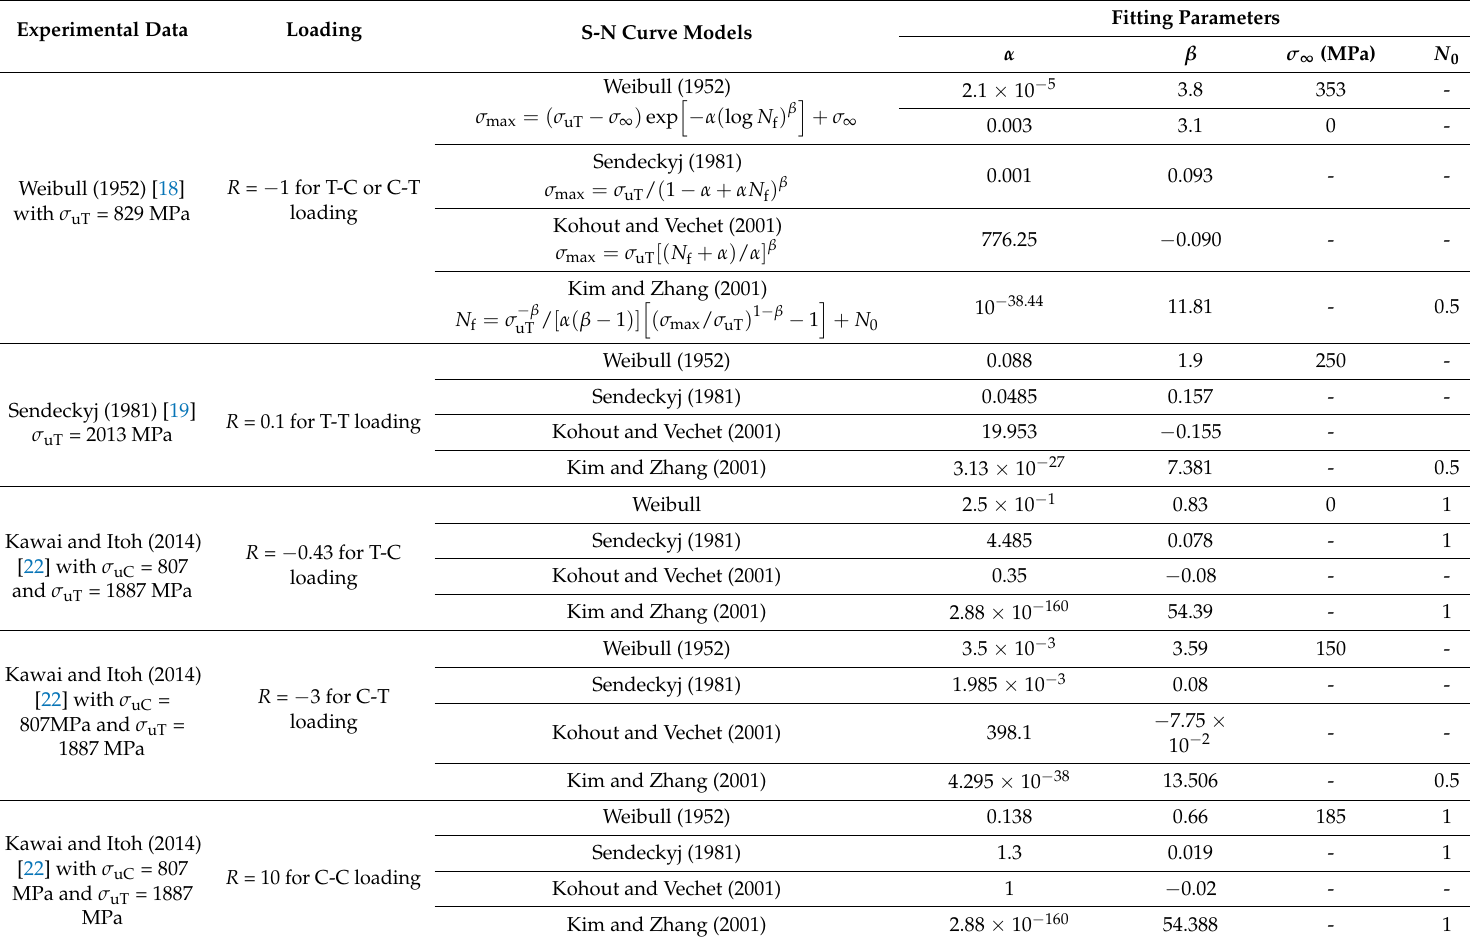
Table 2. Summary of S-N curve models for data characterization proposed by Weibull, Sendeckyj, Kohout and Vechet, and Kim and